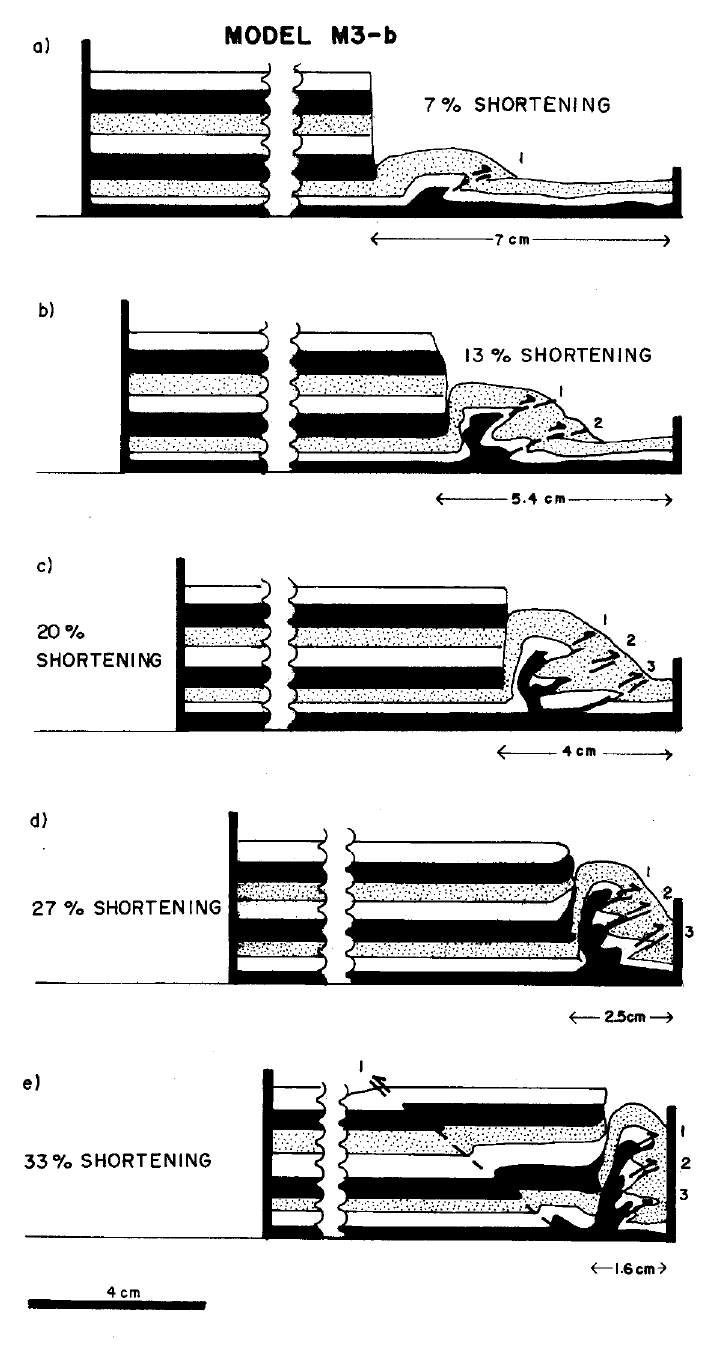
Fig. 12 – Five successive stages of model M3-b (high obstacle, initially thin and short sand layer and deformable backstop). The experiment, after (a) 7%; (b) 13%; (c) 20%; (d) 27%; and (e) 33% shortening. Note the same deformation pattern as in model M3-a. However, the shorter contractional domain and the deformable backstop produce a more homogeneous geometry in the antiformal stack.